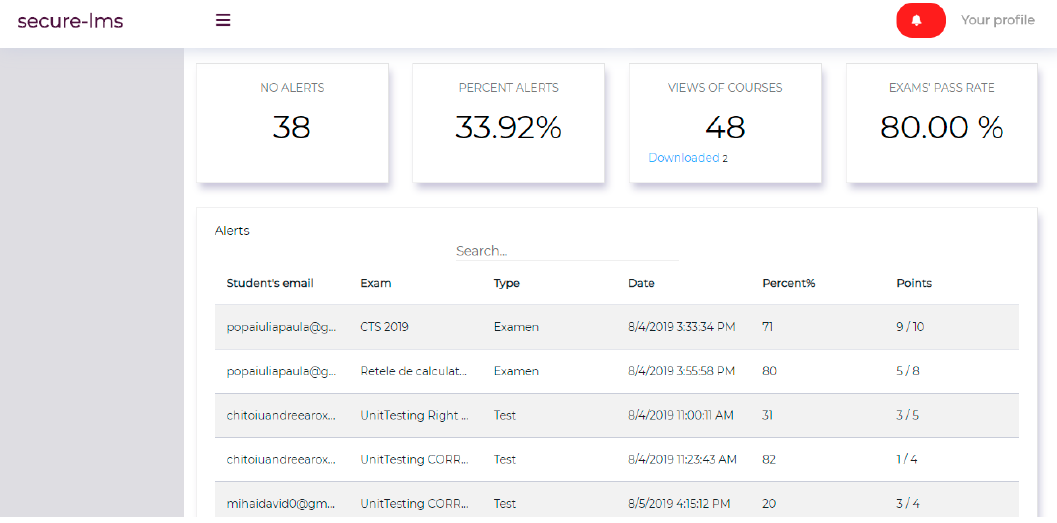
Figure 2. Unauthorized users identified.